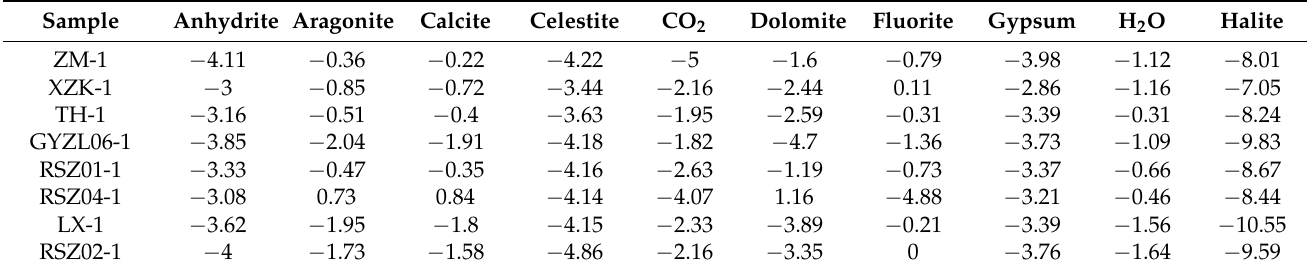
Table 4. Saturation indices for the minerals in Suichuan County. Very few minerals exhibited positive values > 0 showing saturation to oversaturation, while most of the minerals under saturation yielded negative values < 0.